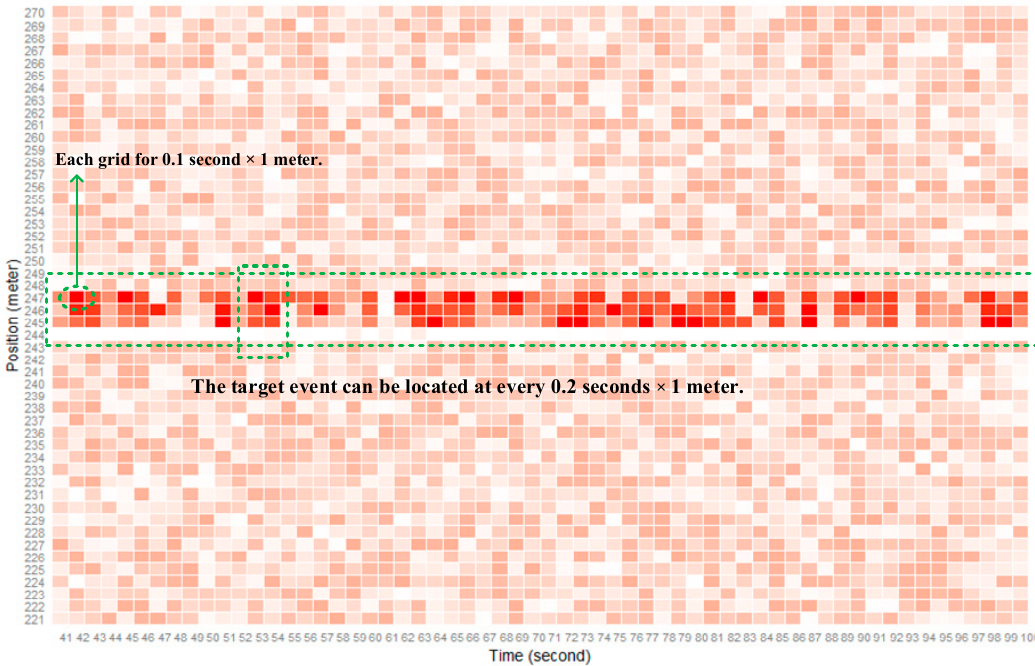
Figure 7. Standard signal location map based on AMNBP.